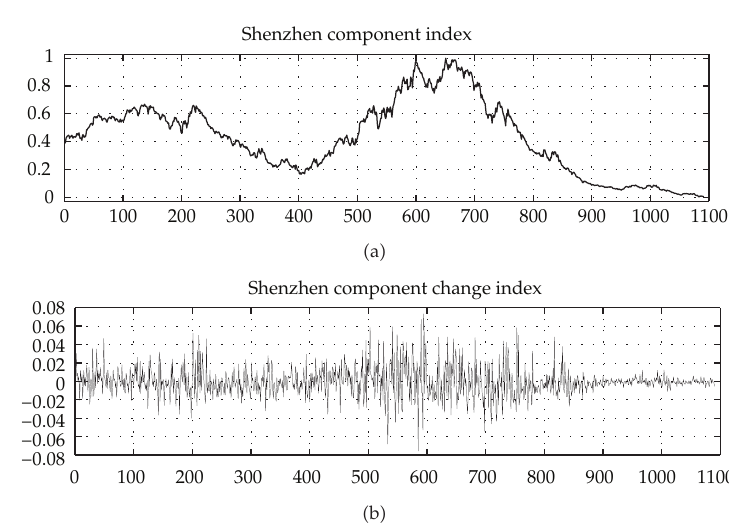
Figure 1: Result of Shenzhen component